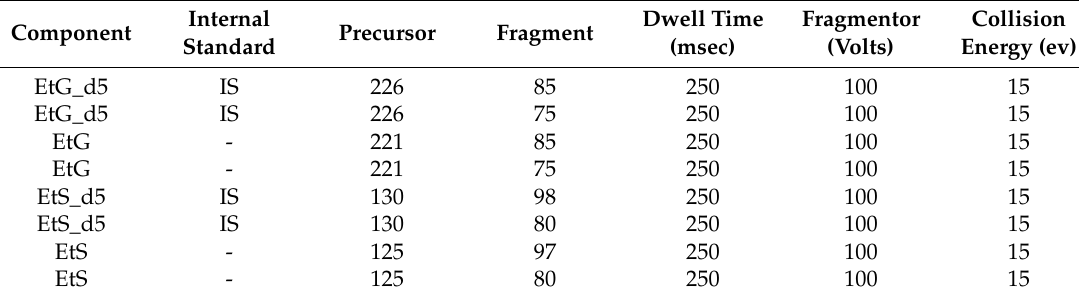
Table 3. Summaries of multiple reaction monitoring (MRM) for 8